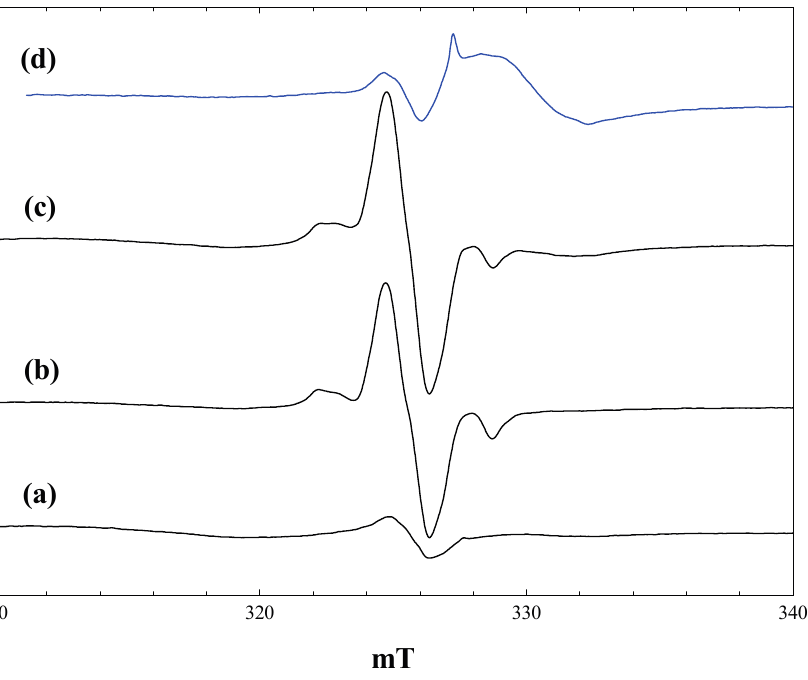
Figure 7. EPR spectra of P25 titania in an equimolar mixture of maleimide and phenoxyacetic acid in acetonitrile. (a), during irradiation with high intensity 400 nm light at 4 K; (b), during irradiation with high intensity broad band light at 4 K; (c), after irradiation with high intensity broad band light at 4 K; (d), after irradiation with high intensity broad band light at 80